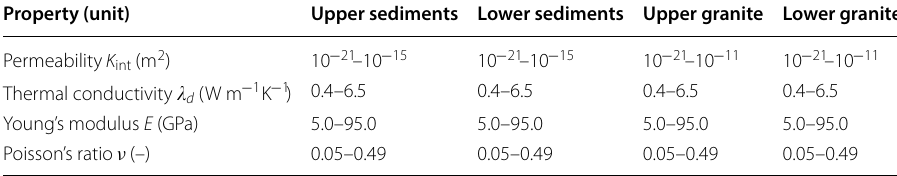
Table 3 Ranges of tested values during the back analysis called “prior distributions” Property (unit)